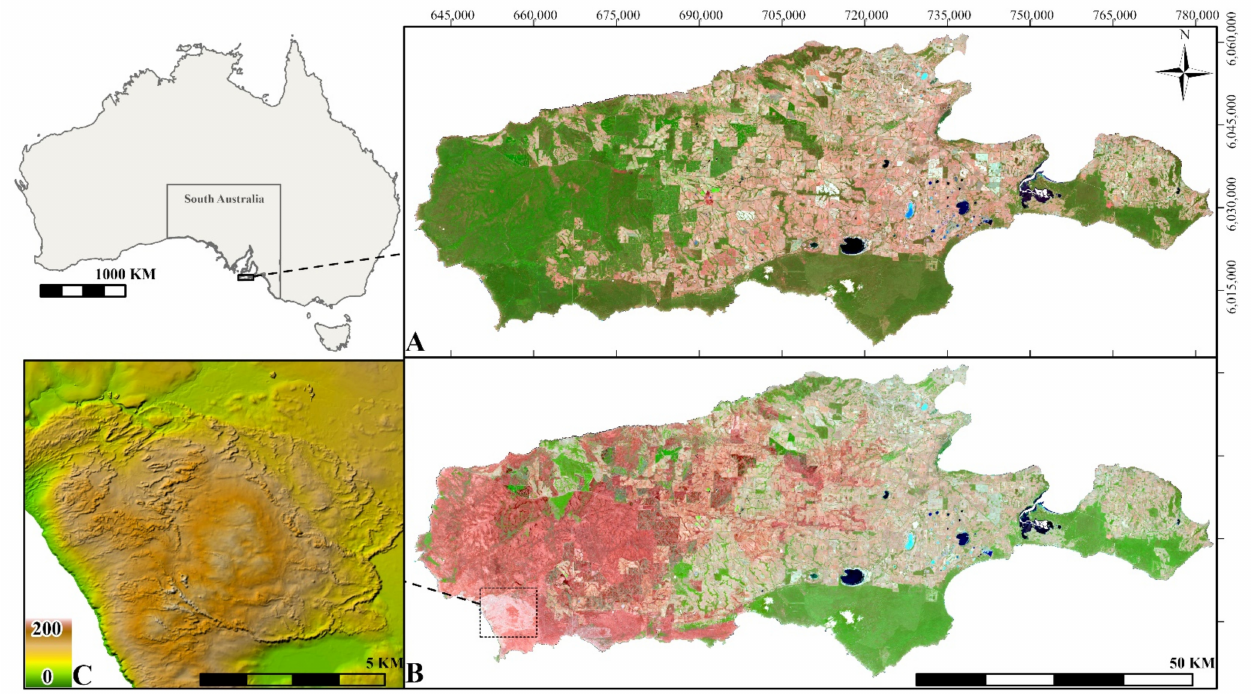
Figure 1. Kangaroo Island in South Australia as shown by Sentinel 2 MSI (L2A) satellite imagery from 16 December 2019 ( A ) and 30 January 2020 ( B ). S2 imagery is shown in bands 4, 8 and 12 (BGR)to highlight fire affected areas. Inset ( C ) shows exaggerated (2 × elevation) relief map (metres) of the Holocene transgressive